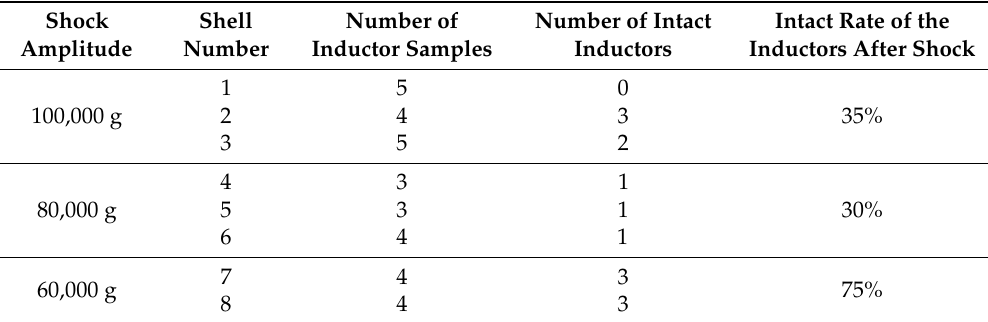
Table 1. The results of shock